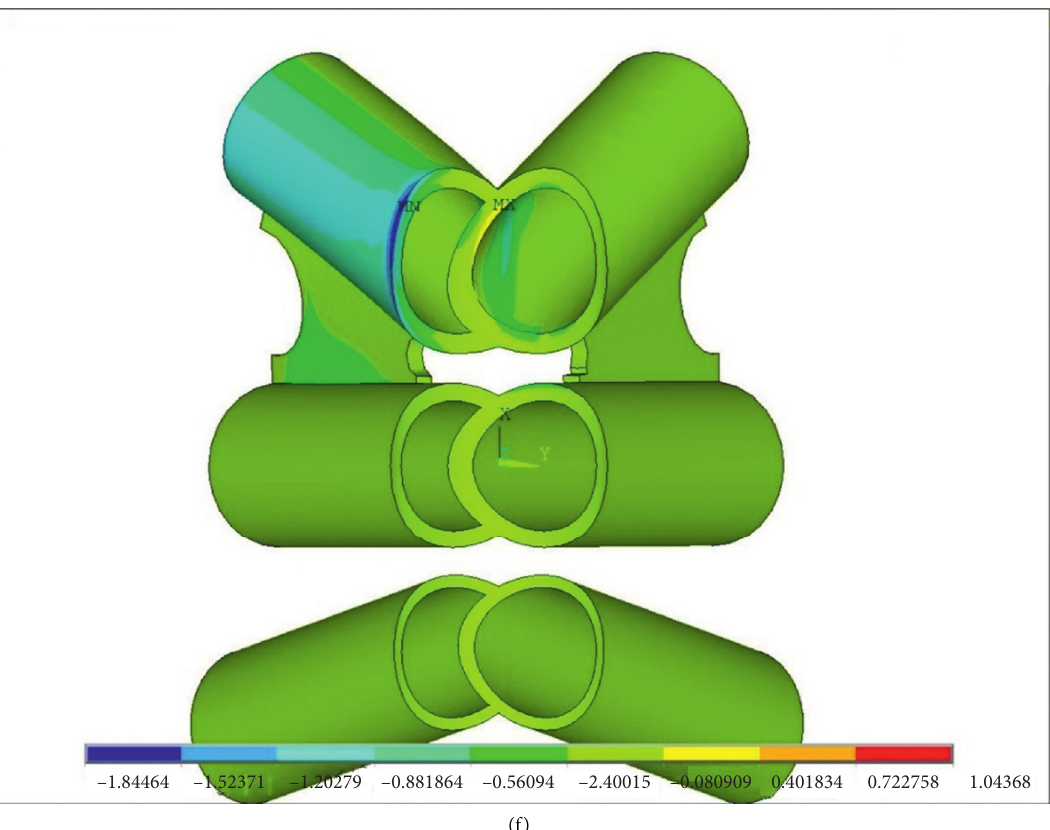
Figure 4: Stress contours of the bracket-stiffened two-planar overlapped KT-joint: (a) the chord and (b) overlapping braces with brackets under axial loading of unit pressure, (c) the chord and (d) overlapping braces with brackets under in-plane bending of unit moment, and (e) the chord and (f) overlapping braces with brackets under out-of-plane bending of unit